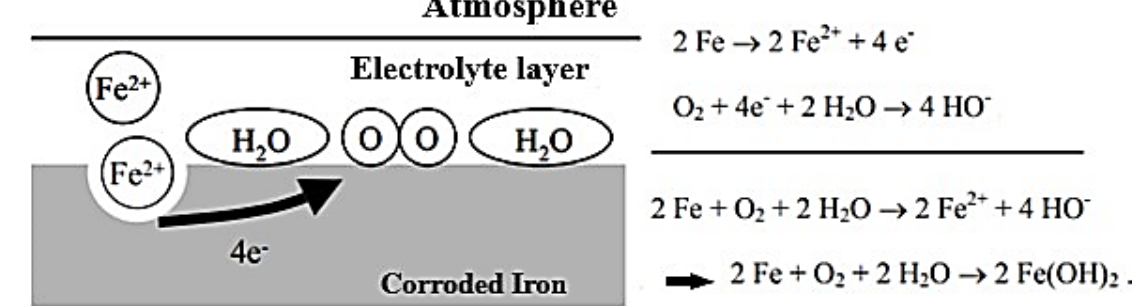
Figure 3. Diagram of the atmospheric corrosion process at the surface with the reaction balance involved.